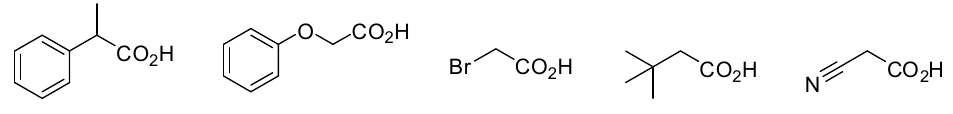
Figure 1. Carboxylic acids unable to furnish multicomponent adduct 3